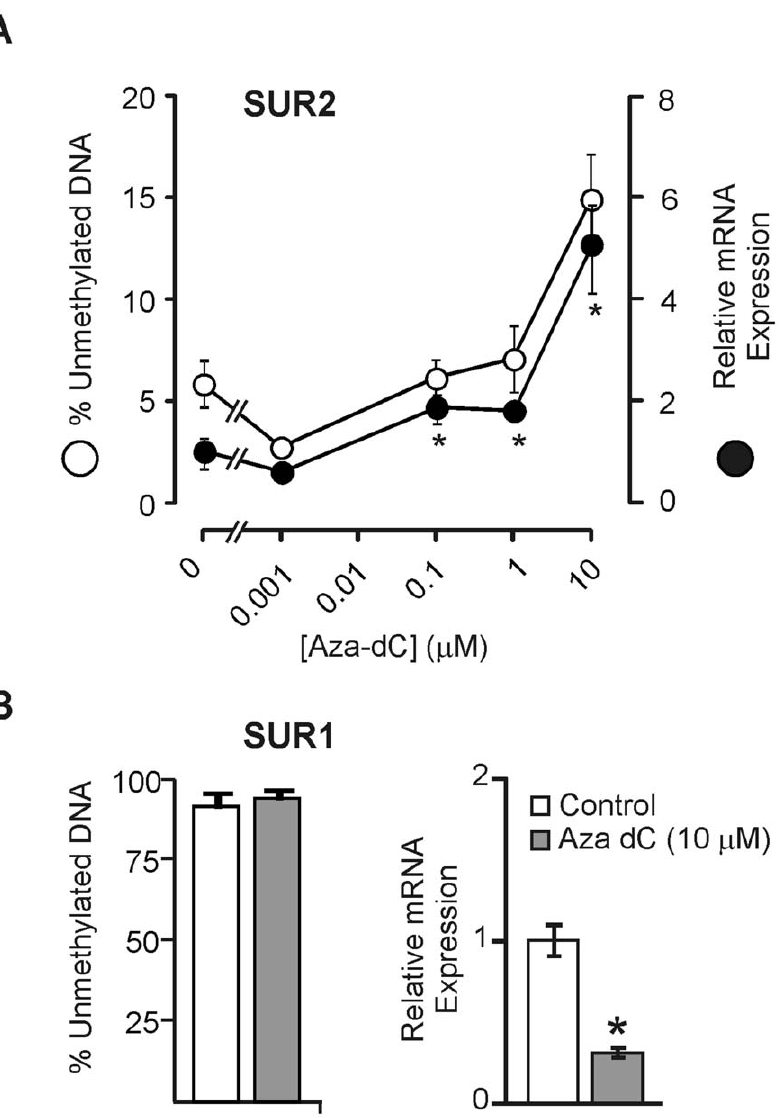
SUR1 CpG island fraction and SUR1 subunit mRNA expression before and after treatment with 10 m M Aza-dC. Taken together, these results indicate that CpG methylation suppresses SURx expression, but that other indirect factors are also likely